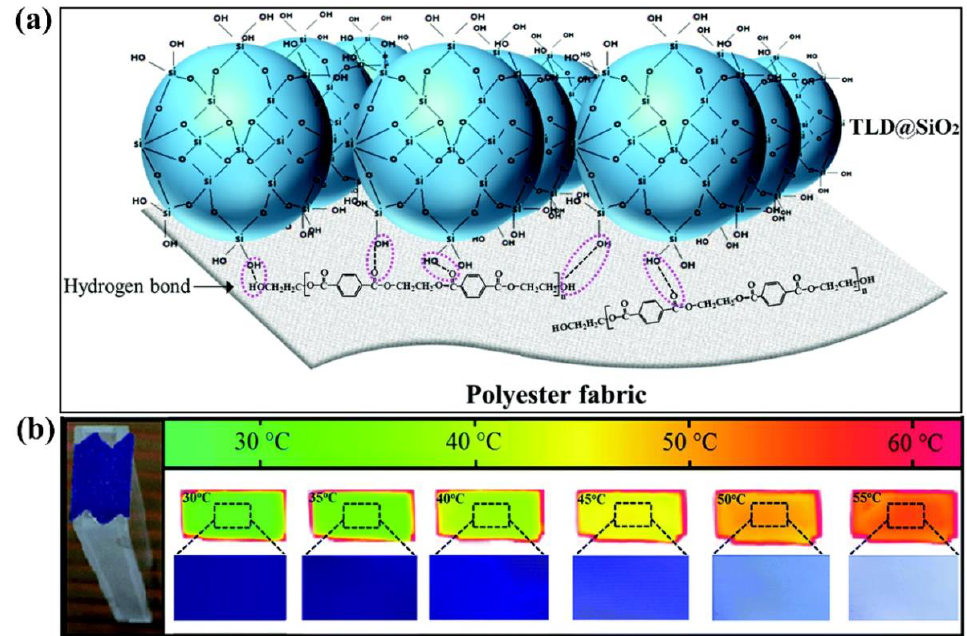
Figure 7. Schematic diagram of fluorescent polyester. ( a ) Schematic illustration of dyeing PET fabric with TLD@SiO 2 . Adapted with permission from [189]. Copyright 2017, Royal Society of Chemistry. ( b ) Reversible color change of thermochromic PET fabric under different temperature. Adapted with permission from [189]. Copyright 2017, Royal Society of Chemistry.